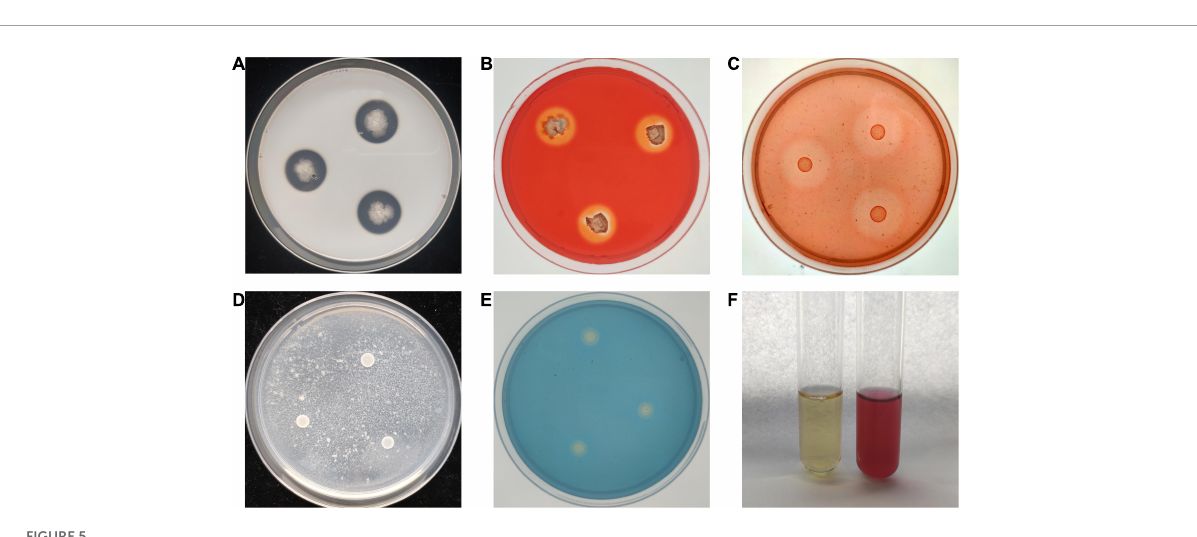
FIGURE5 Detection of antagonistic enzymes and secondary metabolites in B. velezensis BR-01. (A) Protease detection; (B) cellulase detection; (C) β -1,3-glucanase detection; (D) chitinase detection; (E) siderophore detection; (F) indole-3-acetic acid (IAA)